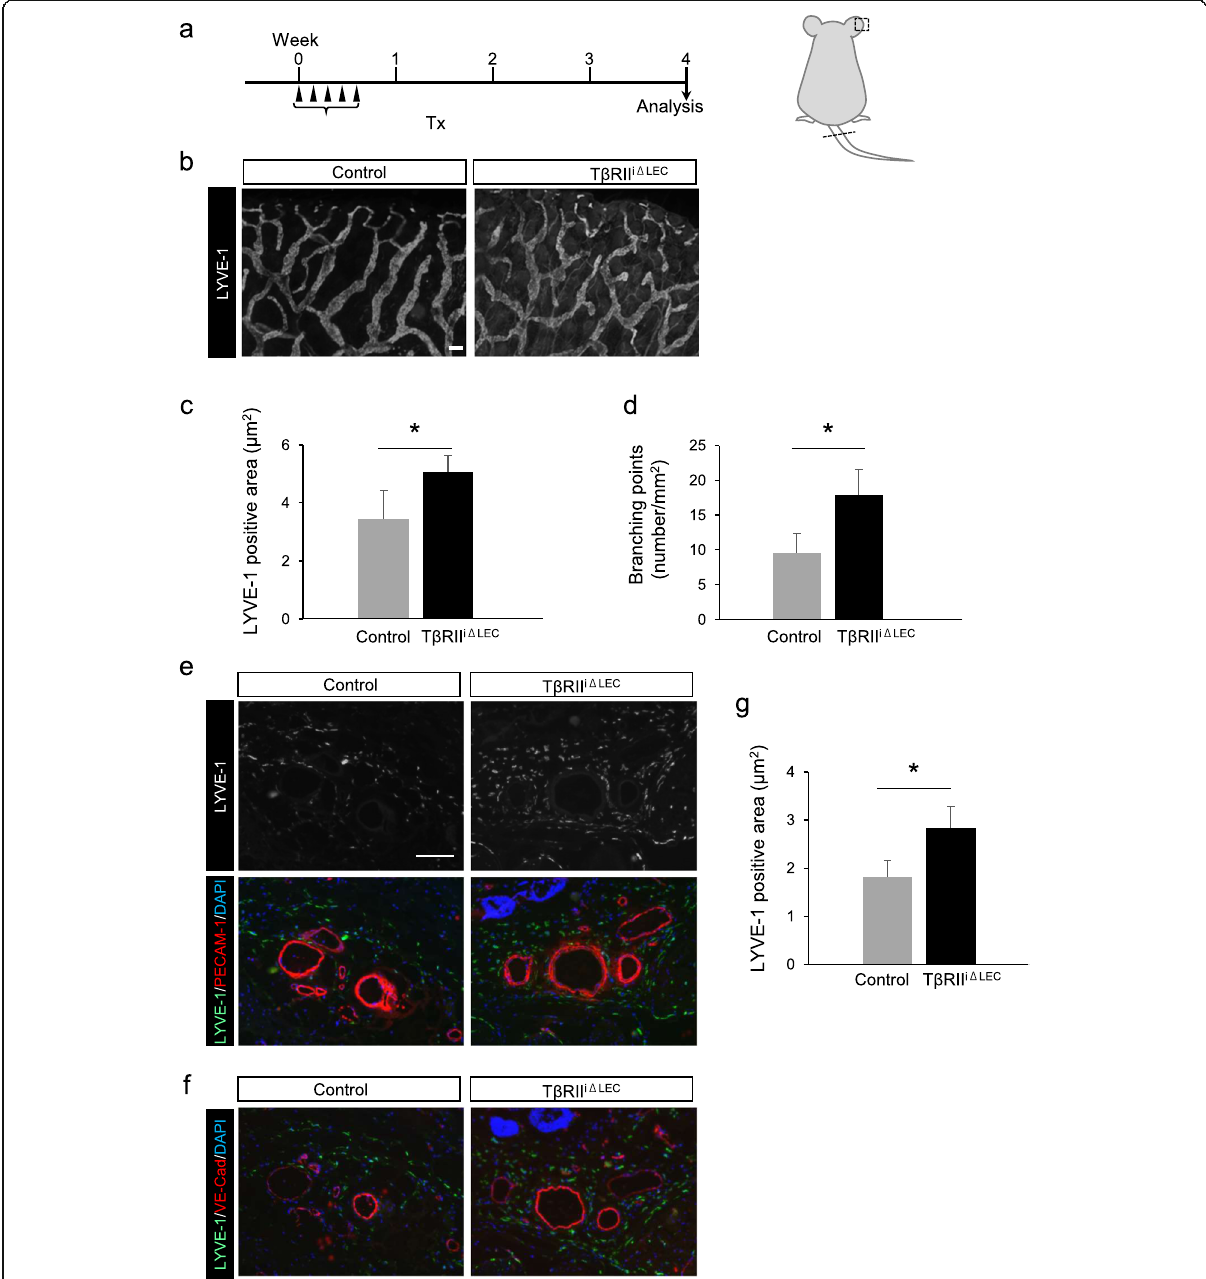
Fig. 2 Lymphatic vessels increase in T β RII i Δ LEC mice. a . Experimental schedule. Mice were treated with i.p. tamoxifen (40 mg/kg) for five consecutive days and sacrificed at day 22 (3 weeks). The ears shown using the dotted square and the tail shown using the dotted line were analyzed. b Whole- mount LYVE-1 staining of ear skin from control and T β RII i Δ LEC mice. Representable images are shown. Scale bar: 100 μ m. c . Image-based analysis of LYVE-1-positive lymphatic vessel area. The average of LYVE-1-positive area in T β RII i Δ LEC mice ( n = 4) was significantly higher than that in control mice ( n = 4). d Number of branching points of lymphatic vessels. The average of the branching number in T β RII i Δ LEC mice ( n = 4) was significantly higher than that in control mice ( n = 4). e , f Immunohistostaining of the transverse section of the mice tails with anti-LYVE-1 (green) and anti-PECAM-1 (red) ( e )/VE-Cadherin (red) antibodies ( f ). Sections were counterstained with DAPI (nucleus, blue). Scale bar: 100 μ m. g Image-based analysis of LYVE-1- positive lymphatic vessel area of Fig. 2e from control ( n = 3) and T β RII i Δ LEC mice ( n =